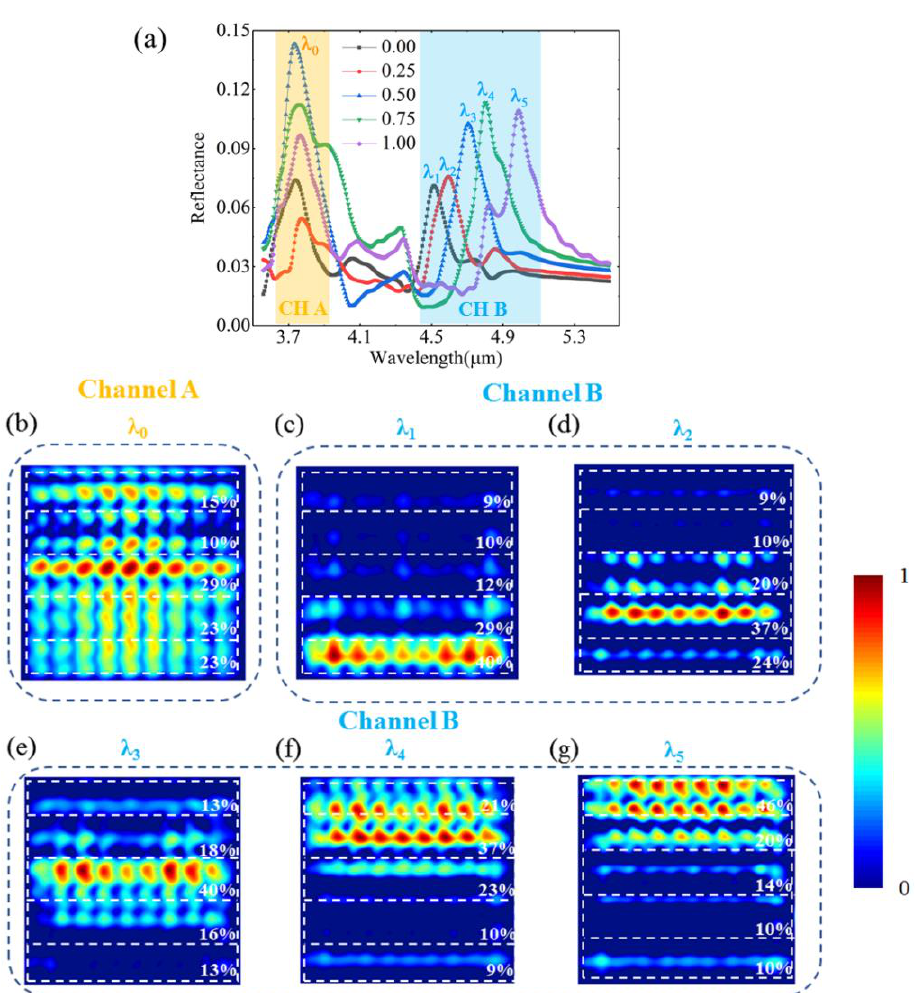
Figure 8. ( a ) Reflectance spectra of different crystalline fraction areas; ( b ) magnetic field distribution in channel A at λ 0 ; magnetic field distributions in channel B at ( c ) λ 1 , ( d ) λ 2 , ( e ) λ 3 , ( f ) λ 4 , and ( g ) λ 5 .